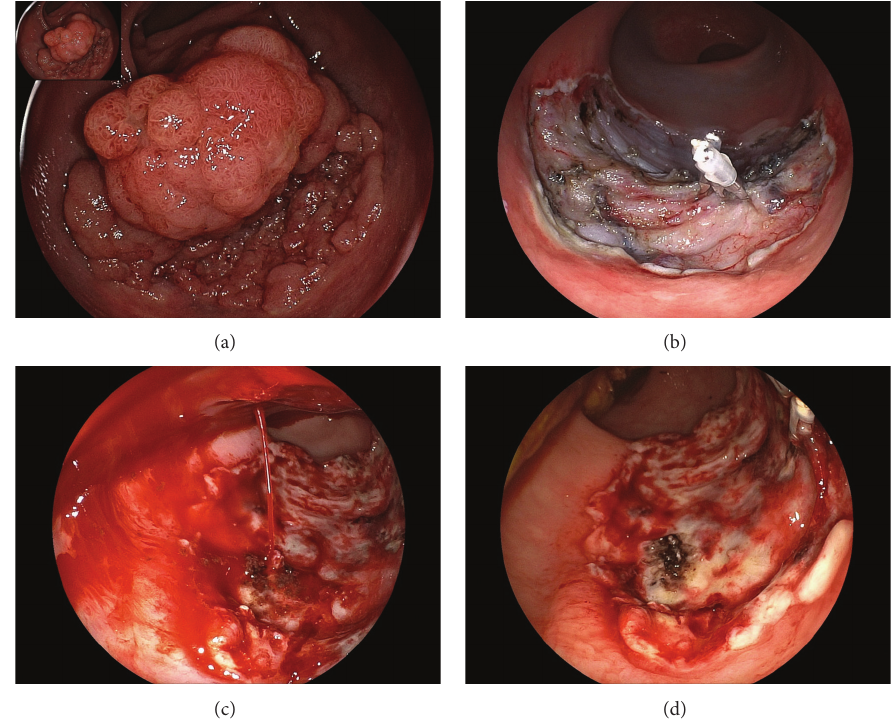
Figure 6: (a) Rectal tumor, 0-IIa, 50mm in diameter. (b) The ulceration after endoscopic submucosal dissection (ESD). (c) Pulsing hemor- rhage occurred 4 days after ESD. (d) The vessel was coagulated by hemostatic forceps.